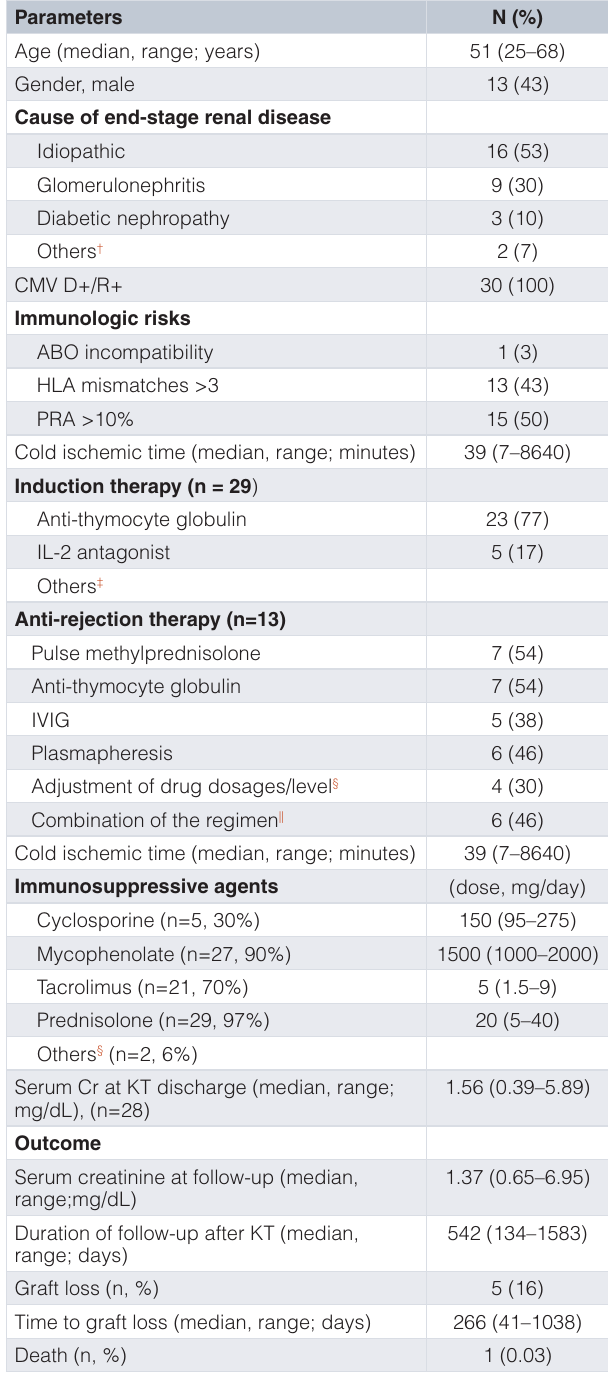
Table 1. Patients’ baseline characteristics, treatment and outcome (n =